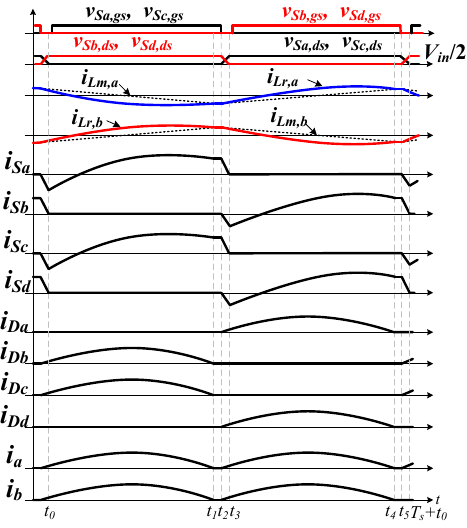
Figure 4. Main current and voltage signals of the LLC converter.